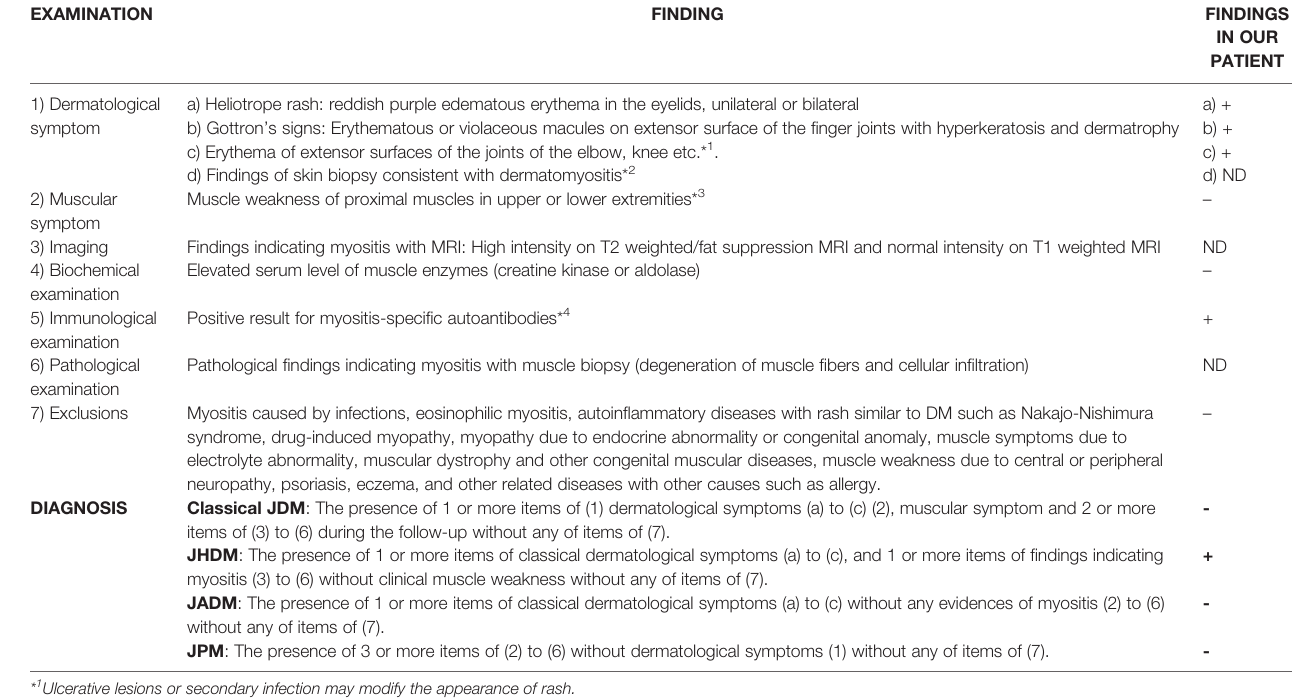
TABLE 1 | Clinical practice guidance table for the diagnosis of juvenile dermatomyositis (9) and results in our